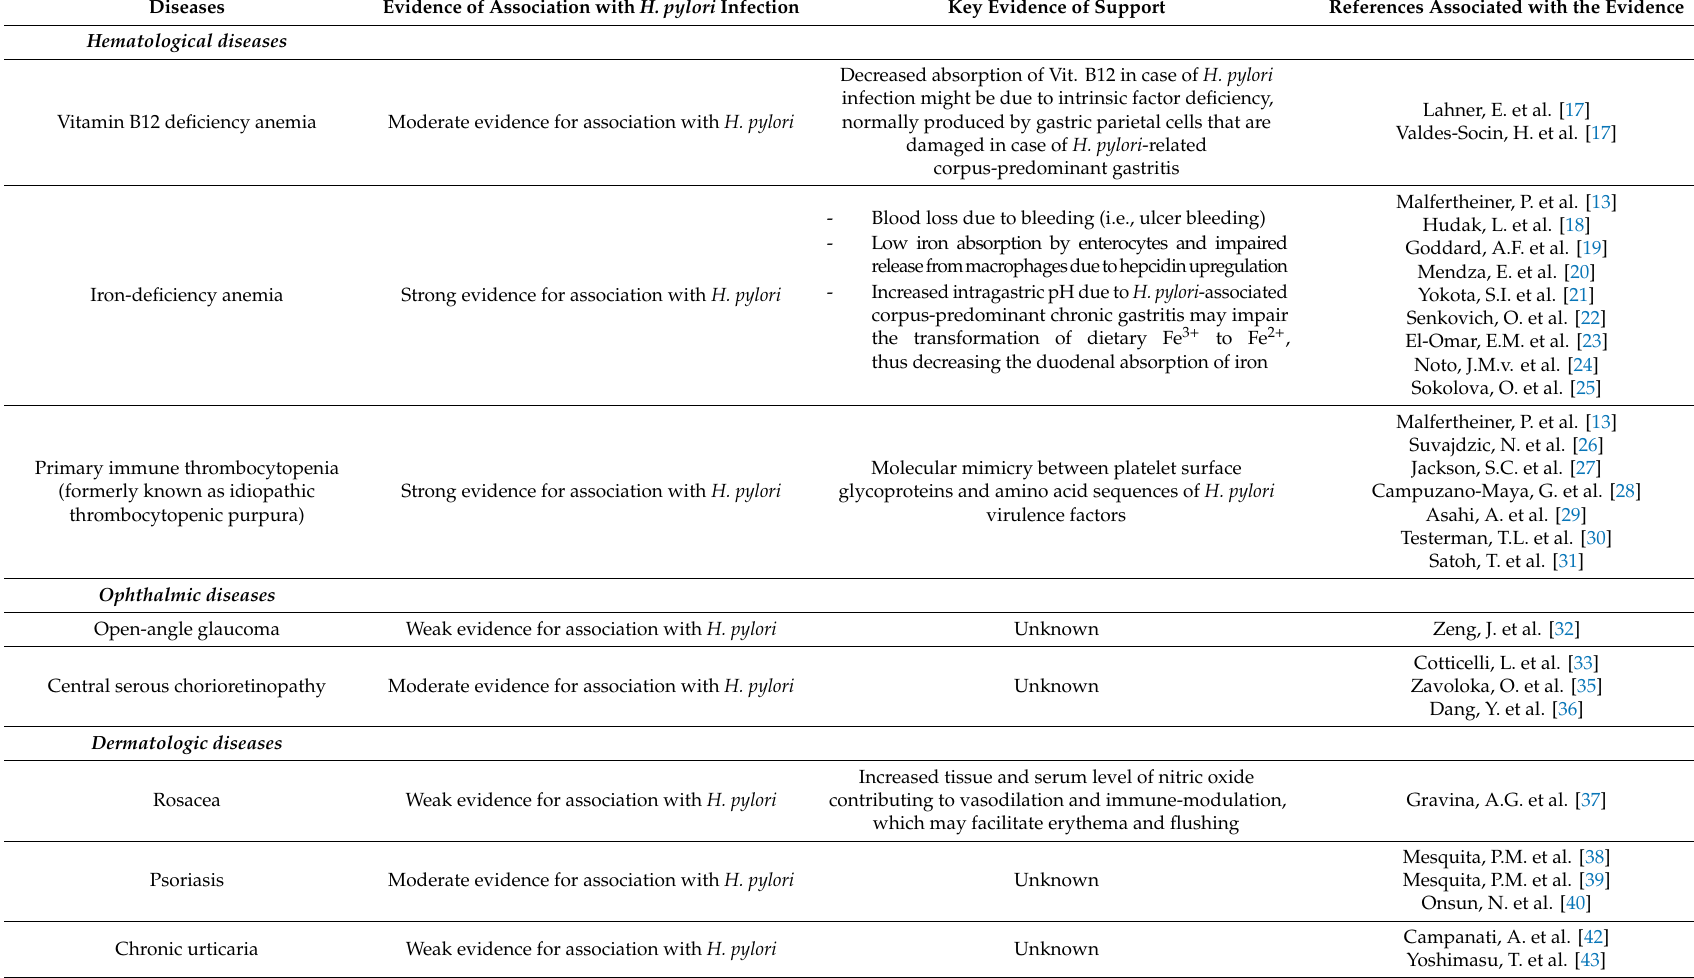
Table 1. Association between H. pylori infection and extra-gastric